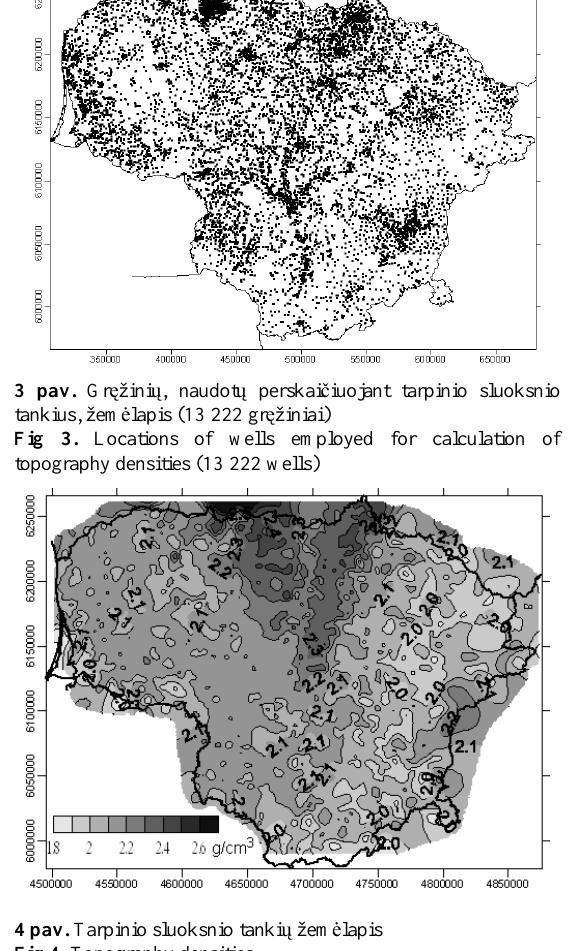
Fig 6. Mass deficit of new density model (compared to old